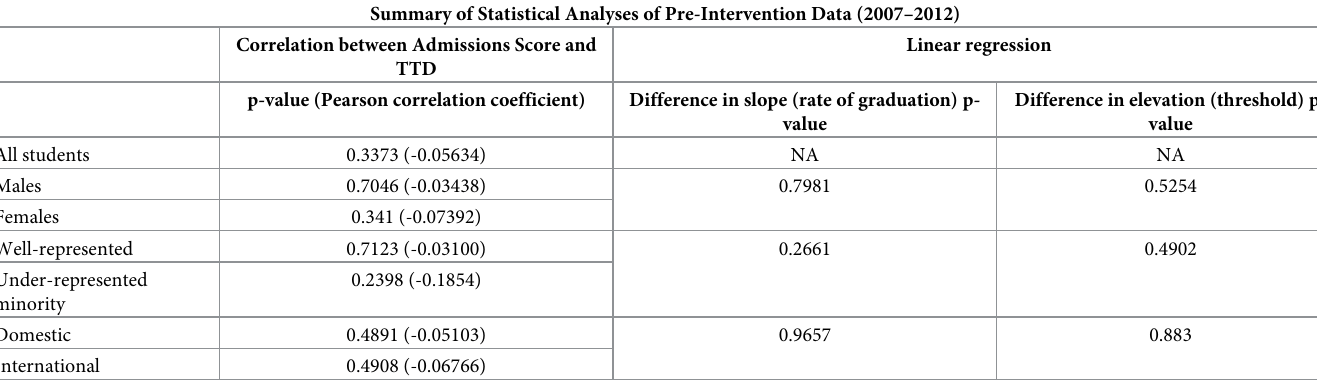
Table 1 summarizes the statistical analyses that were conducted on each data set regarding admissions scores and time to degree. None of the data that was analyzed showed statistically significant correlations or differences in slope or elevation regardless of gender (Fig 1B), race and ethnicity (Fig 1C), or citizenship (Fig